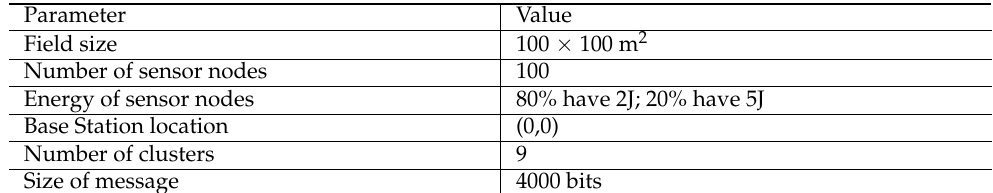
Table 1. Simulation parameters.